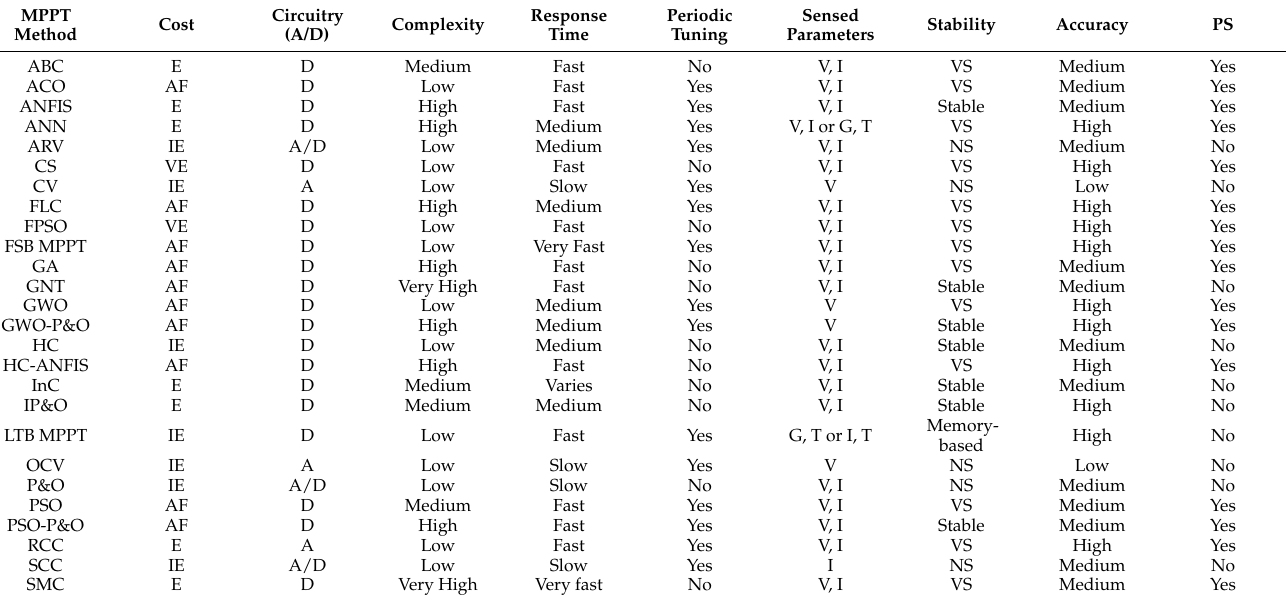
Table 8. ComparisonofdifferentMPPTtechniques(reconstructedbyauthorswithdatafrom[44,50,129,130]). MPPT